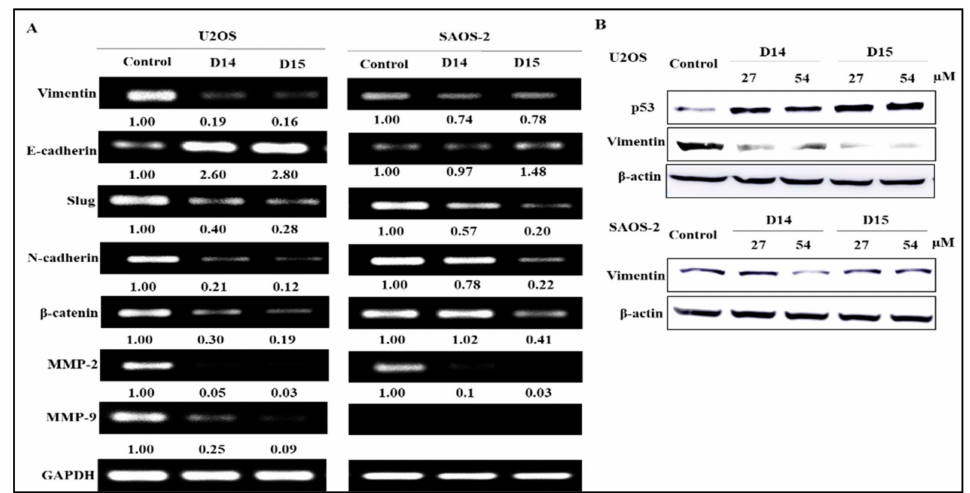
Figure 4. Effects of D14 and D15 on the expression of MMPs and epithelial-mesenchymal transition (EMT)-related genes. ( A ) Osteosarcoma cells were treated with 54 µ M of D14 and D15 in serum-free medium for 24 h (control: cells treated with 0.1% DMSO). Next, total RNA was isolated and subjected to conventional RT-PCR. Representative gel and densitometry analyses are shown. The image intensities of the bands were normalized against the intensity of the GAPDH band. ( B ) Analysis of p53 and vimentin protein expression in osteosarcoma cells treated with D14 and D15 at the indicated concentrations for 24 h. After treatment, cell lysates (30 µ g of total protein) were obtained and subjected to Western blot analysis using anti-p53, anti-vimentin, and anti- β -actin